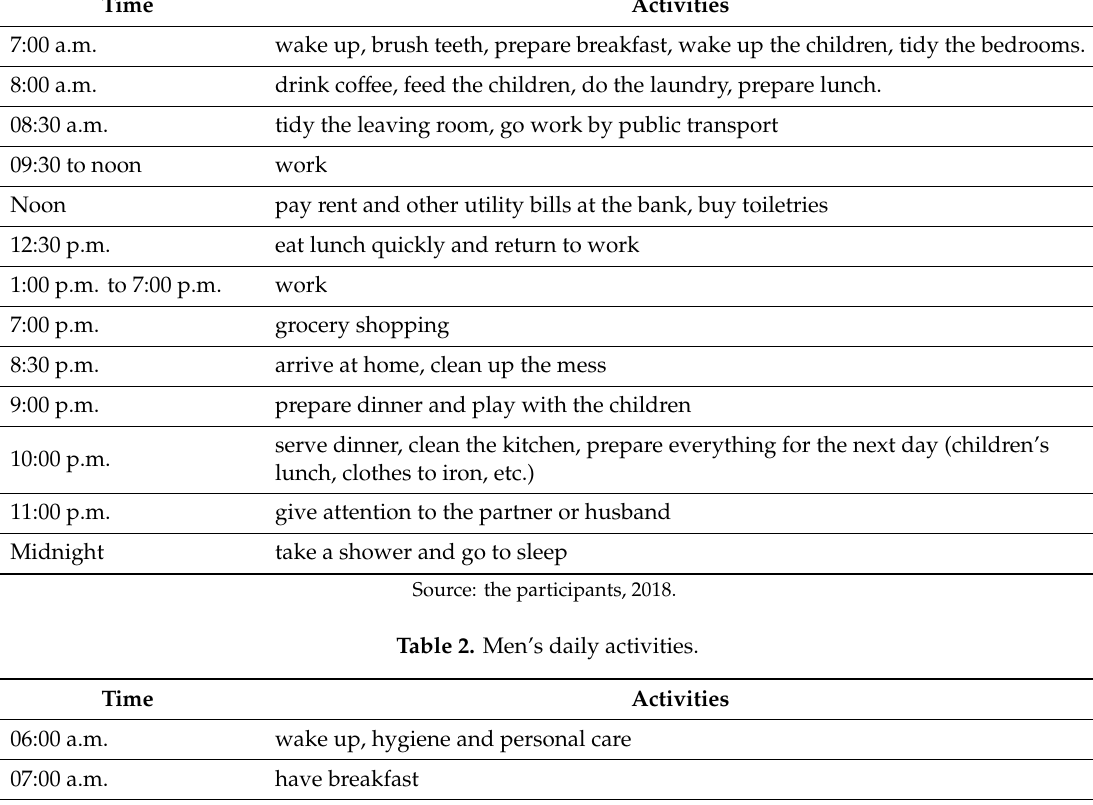
Table 1. Women’s daily activities.